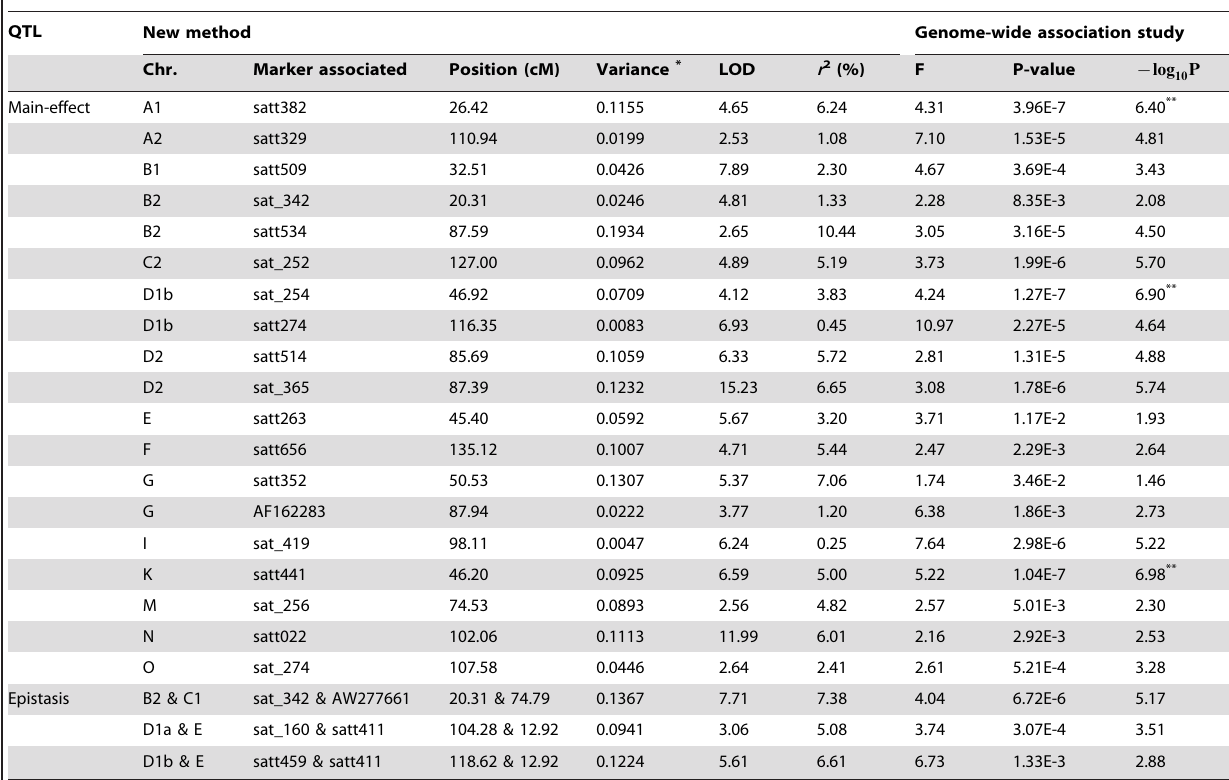
Table 1. Detected QTL for seed length in soybean cultivar